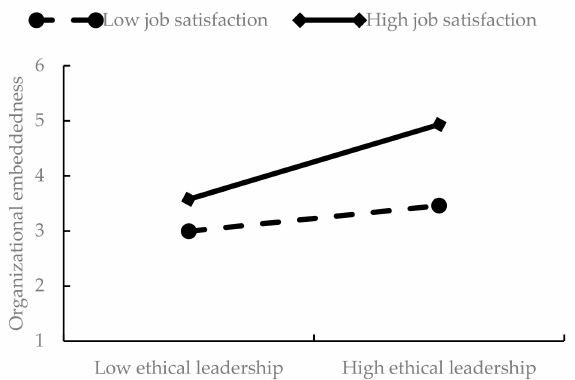
Figure 2. Moderating e ff ect of job satisfaction on the relationship between ethical leadership and organizational